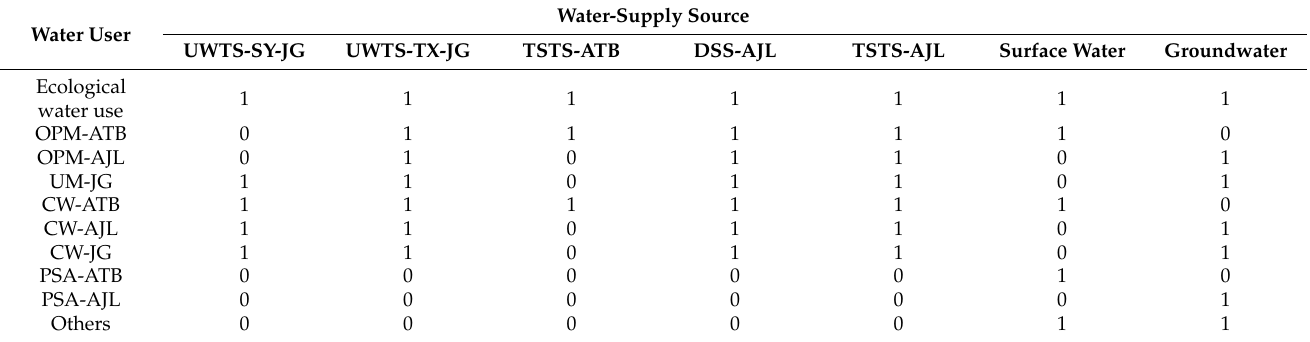
Table 10. Water supply-demand relationship matrix in the study area. The value 1 represents that the water supply source and the water user can establish a supply relationship. The value 0 means that the supply relationship cannot be established between the water supply and the water